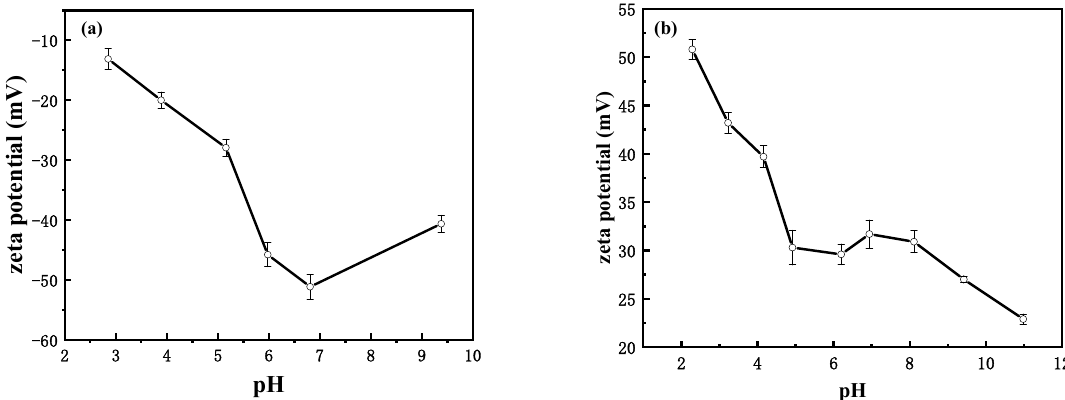
Figure 2. Zeta potentials of the differently charged AuNPs: ( a ) negatively charged AuNPs; ( b ) positively charged AuNPs.